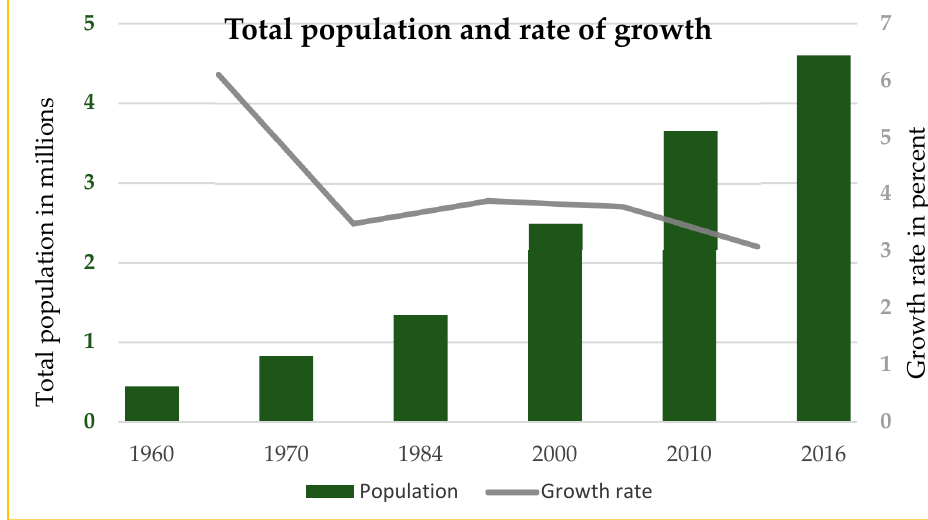
Figure 2. Population growth trends in Greater Accra Metropolitan Area (GAMA).